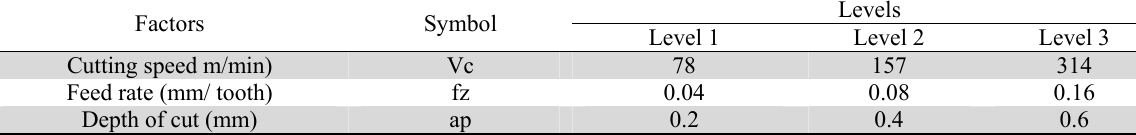
Low–middle–high levels of cutting parameters in three-level full factorial design of experiment